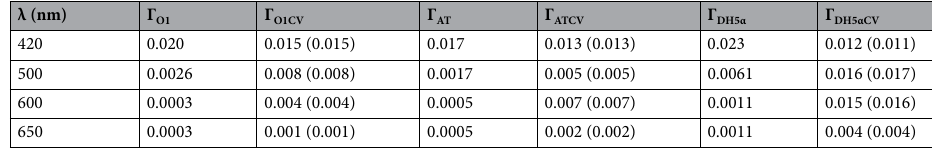
Table 1. Inactivation rate constants versus irradiation wavelength for unstained and stained E. coli strains. The rate constants of unstained samples (Γ O1 , Γ AT , and Γ DH5α ) were determined by experimentally obtained CFU, whereas the rate constants of stained samples (Γ O1CV , Γ ATCV , and Γ DH5αCV ) were theoretically determined by using Eq. (3). Here, we denote the experimentally determined rate constants for stained E. coli strains in the parentheses as a comparison.